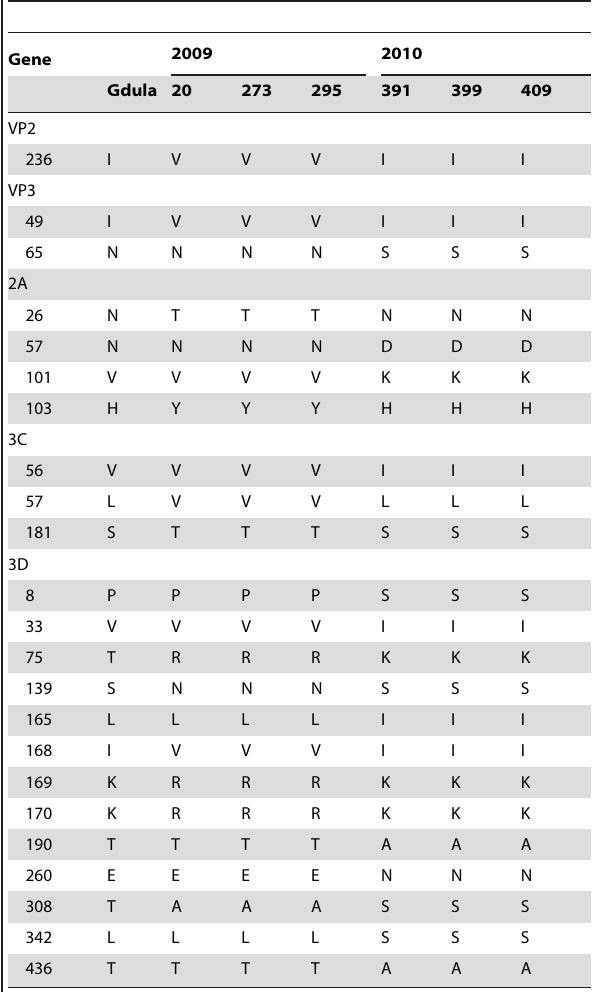
Table 2. The unique amino acid changes of coxsackievirus A6 in 2010.